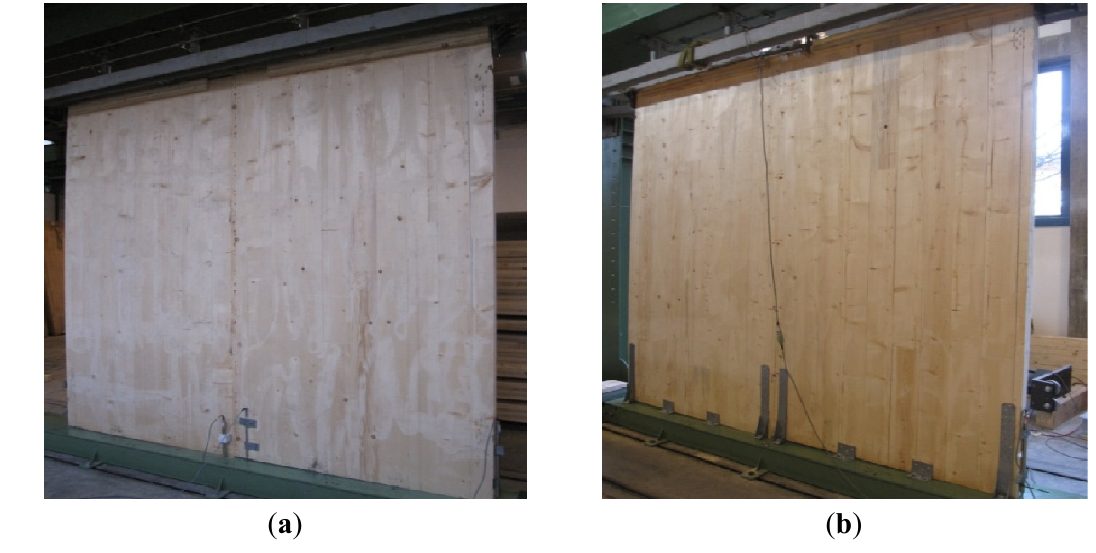
Figure 9. Wall A: Shear deformation between panels at end of testing: ( a ) Rear face; ( b ) Front face.